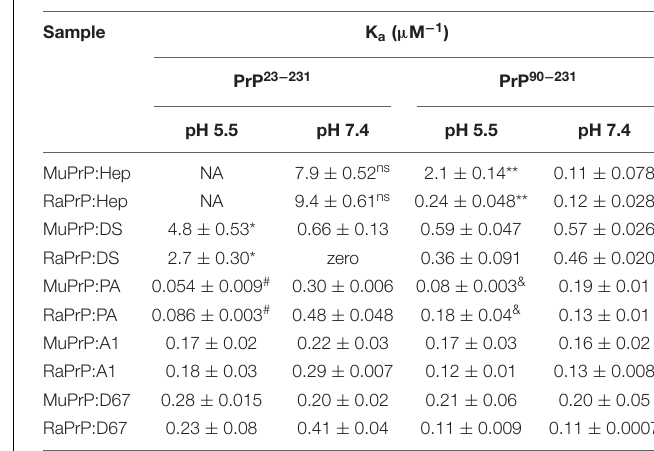
TABLE 1 | Observed association constants for all cofactors